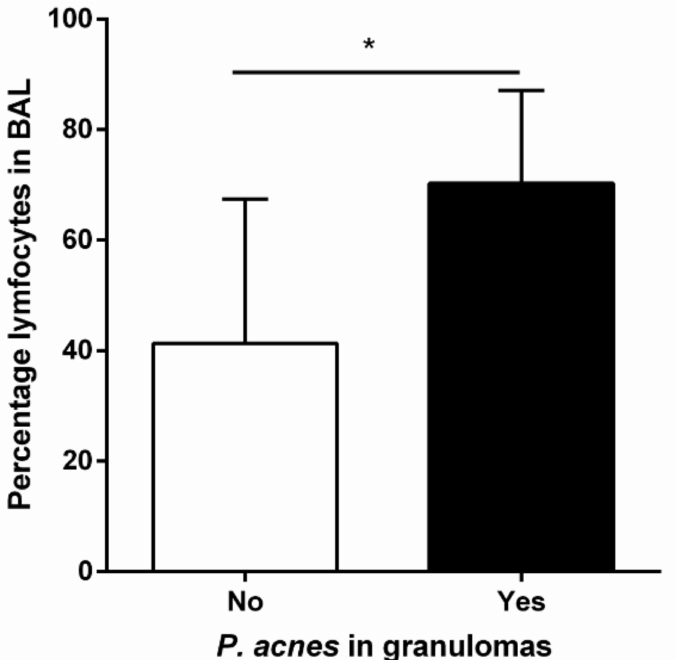
Figure 3. Lymphocyte percentage in the BAL fluid of HP patients with and without the presence of C. acnes in granulomas. Asterisk represents significant difference. BAL: Broncho alveolar lavage, HP: Hypersensitivity pneumonitis. The results of this study are described in